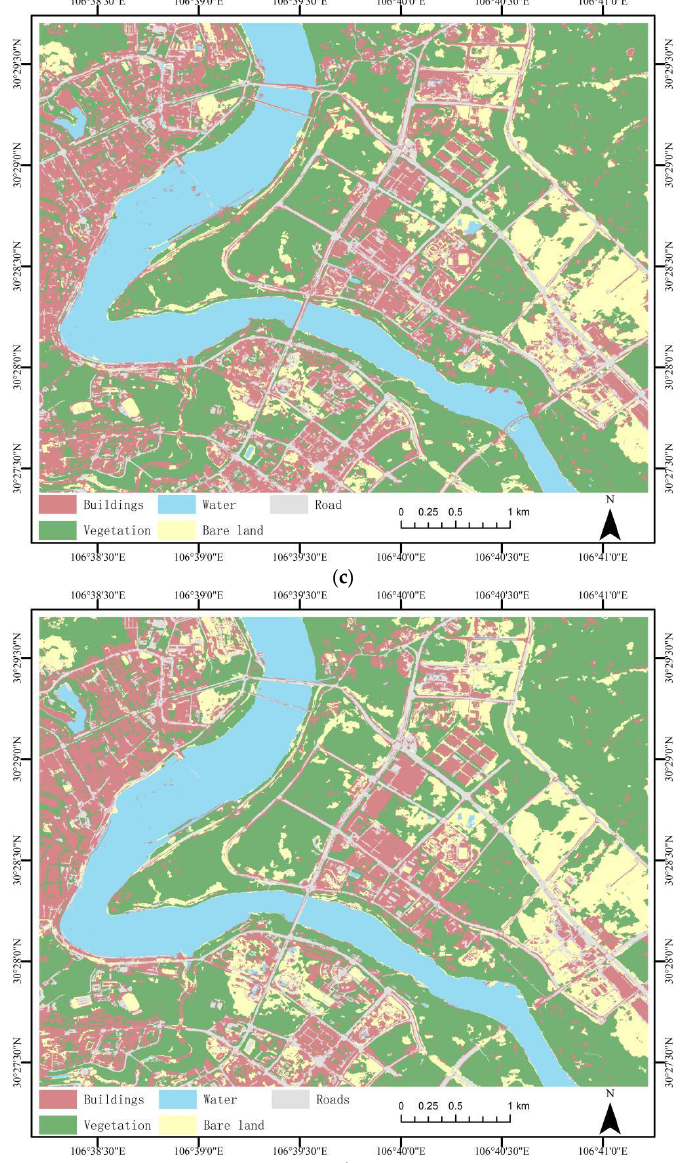
Figure 7. Graph of optimal classification results for different classifiers ( a ) Fisher-CART; ( b ) Fm-RF; ( c ) Fm-KNN; ( d ) mRMR-SVM.